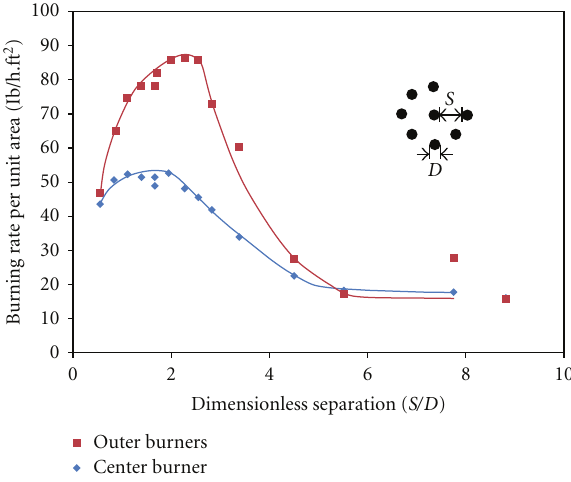
Figure 5: Burning rate as a function of separation distance for 10.1cm diameter cyclohexane burners from [111].